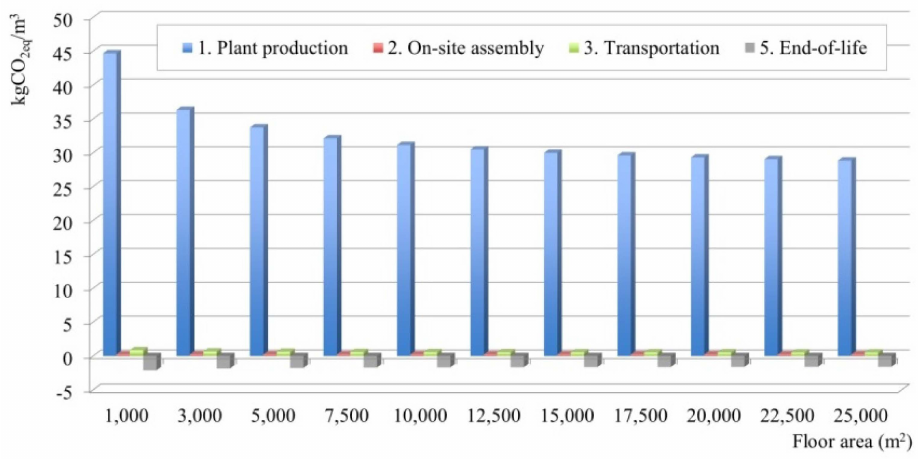
Figure 6. Carbon footprint (reference scenario) as a function of the floor area. The use phase (not shown) is constant (100.12 kgCO 2 eq /m 3 ).